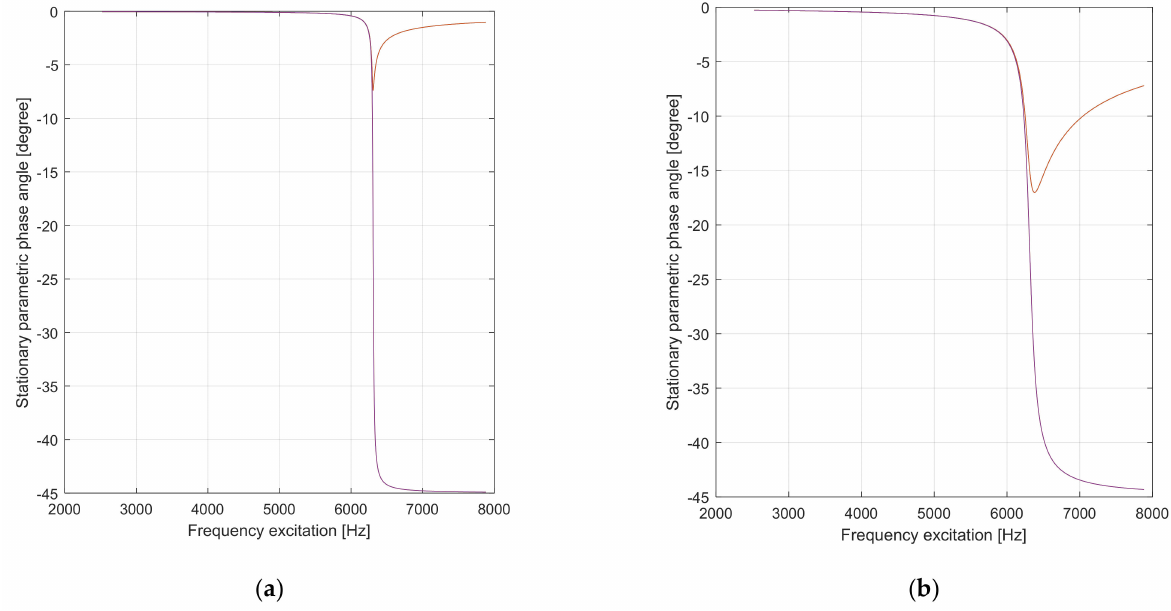
Figure 17. Stationary parametric phase angle Ψ of the bowl for χ nB = 0.10, where µ = 0.754 × 10 − 4 . ( a ) ζ = 0.00016 ( b ) ζ = 0.00016.